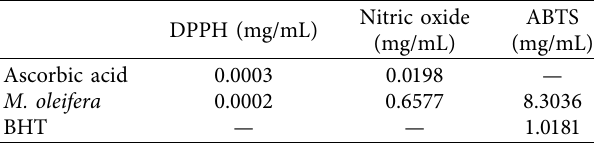
Figure 2. Te IC values of the amylase inhibitory activity of 50 the extract were 0.1802 mg/mL and that of acarbose were 0.1215 mg/mL, as shown in Table 4.